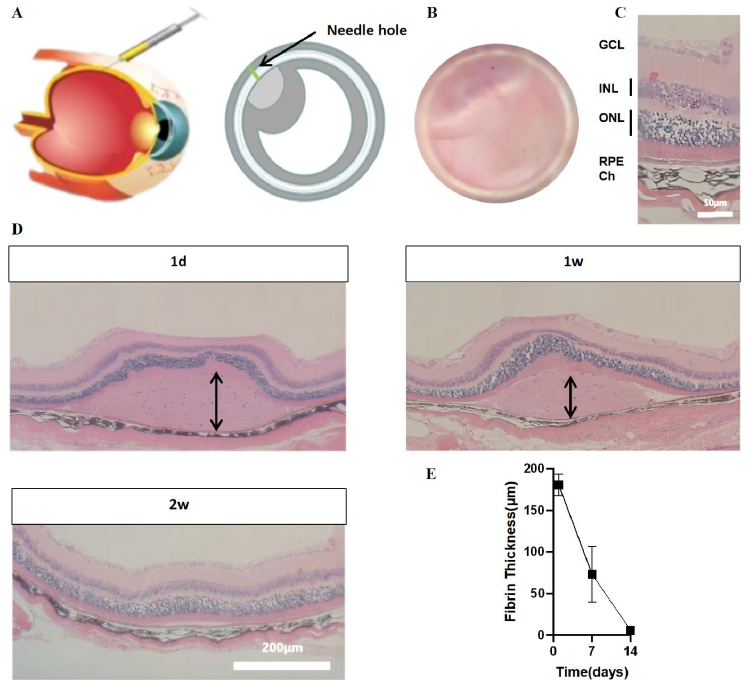
Figure 5. Immunogenicity and degradation of fibrin in the subretinal space. ( A ) Schematic of the subretinal space injection. ( B ) Macroscopic view of injected fundus of a mouse eye. ( C ) Close up image of HE stained histological sections where the injection was administered, revealing the healthy retina. ( D ) Micrographs of HE-stained tissue sections of animals at 1, 7 and 14 days. The fibrin implants were eosinophilic and most of the gel was retained for 1 week. After two weeks, fibrin gels were no longer evident. Both time periods reveal a healthy neuroretina inside the implanted location (arrows indicate fibrin). ( E ) Graph showing the change in fibrin protein thickness over time in animals. Thickness indicates remaining fibronectin implants. GCL: ganglion cell layer. ONL: outer nuclear layer. INL: inner nuclear layer. RPE: retinal pigment epithelium. Ch: choroid.